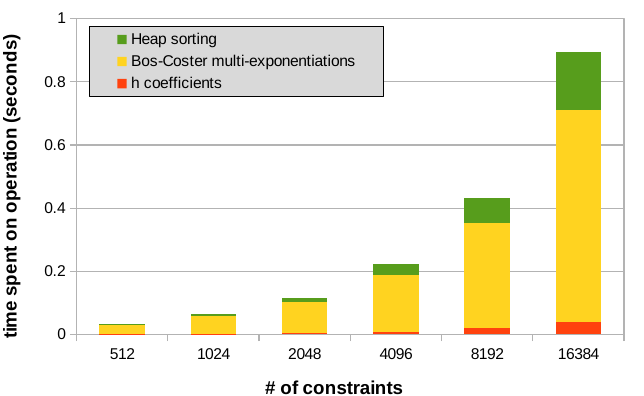
Figure 2. CPUs proving operations workload comparison of ZPiE executed in a i7-11370H CPU in single-thread mode. The used zk-SNARK is Groth’16, and the elliptic curve